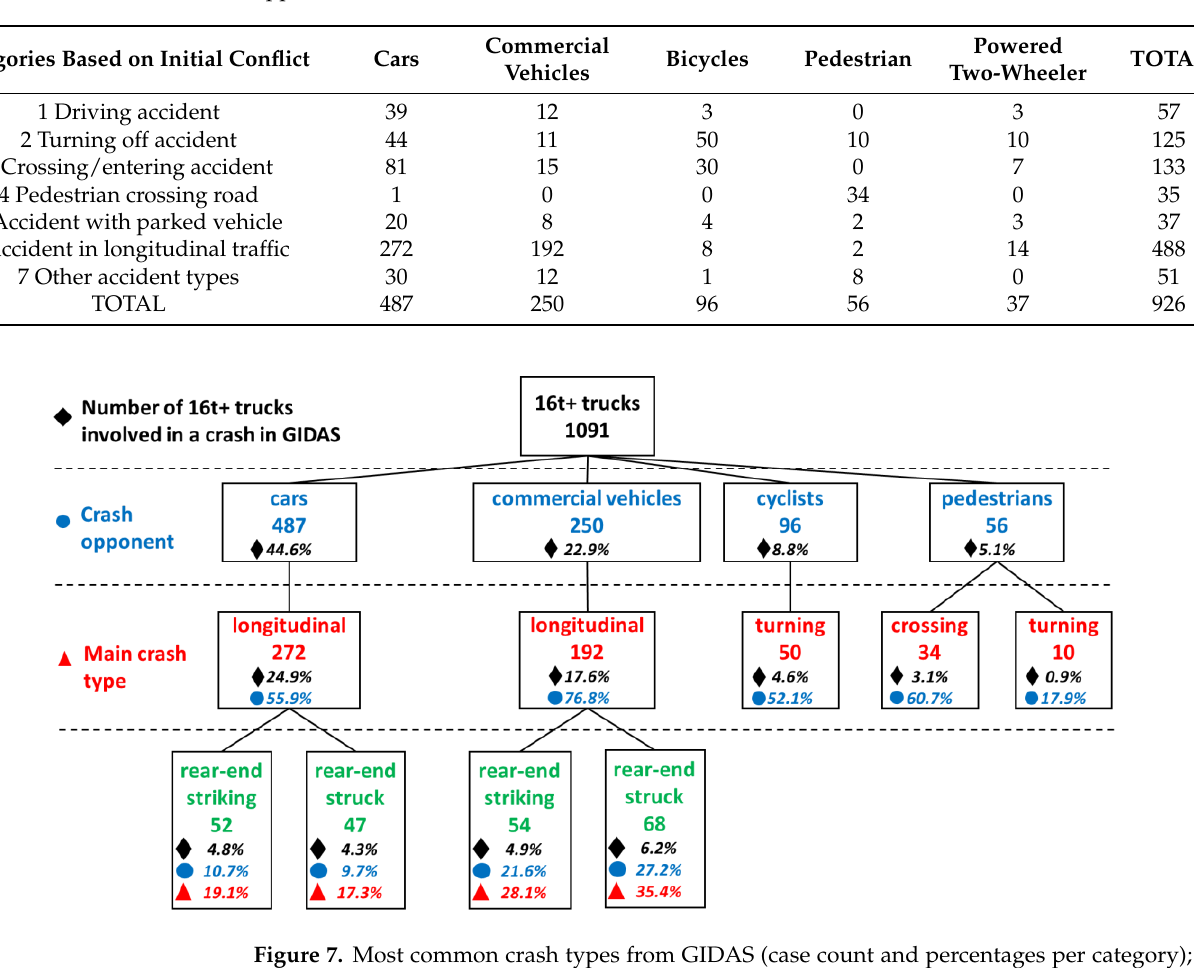
Table 2. Categories of crash types for 16 t+ trucks with different types of road users as crash opponents, based on GIDAS.